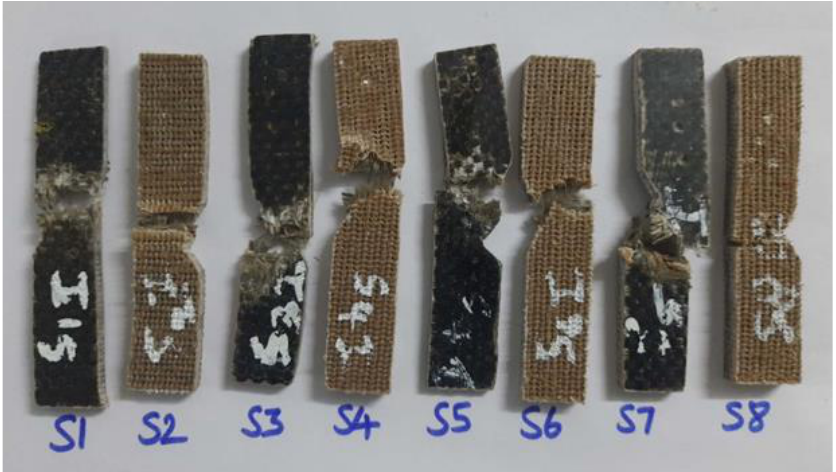
Figure 6. Impact specimen after the test. (S1-BBBBBBBB; S2-RRRRRRR; S3-BBRRRBB; S4-RRBBBRR; S5-BRRBRRB; S6-RBBRBBR; S7-BRBRBRB; S8-RBRBRBR).